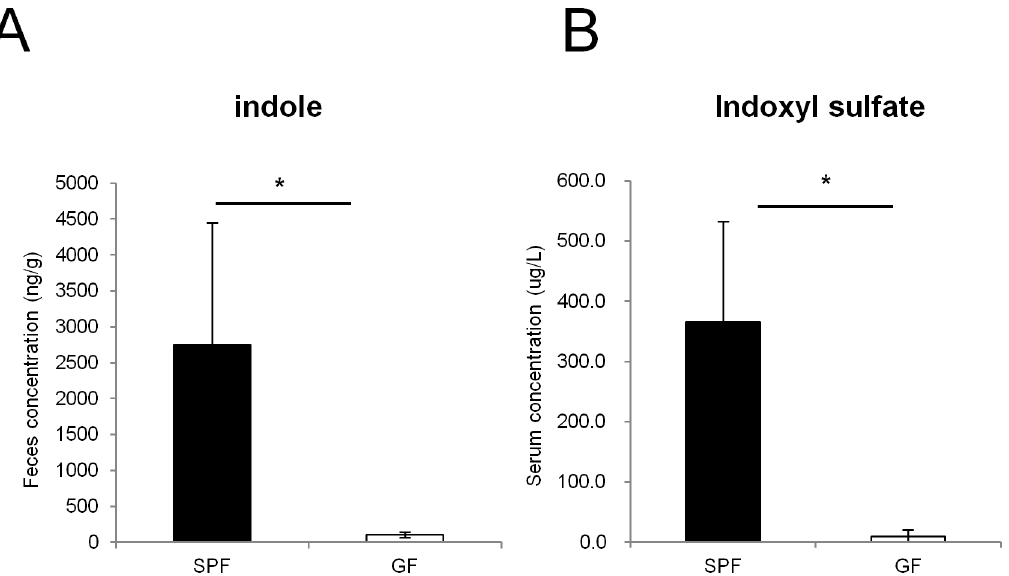
Figure 2. Indole and indole metabolites are absent in GF mice. (A, B) Feces and serum were collected from either SPF (n=3) or GF (n=3) mice. The concentration of indole in the feces was measured by HPLC-FL, and the serum concentration of indoxyl sulfate was measured by LC-MS/ MS. Data are representative of two independent experiments and show mean values 6 S.D. of 3 mice. *P , 0.05. SPF, specific pathogen free; GF, germ free.